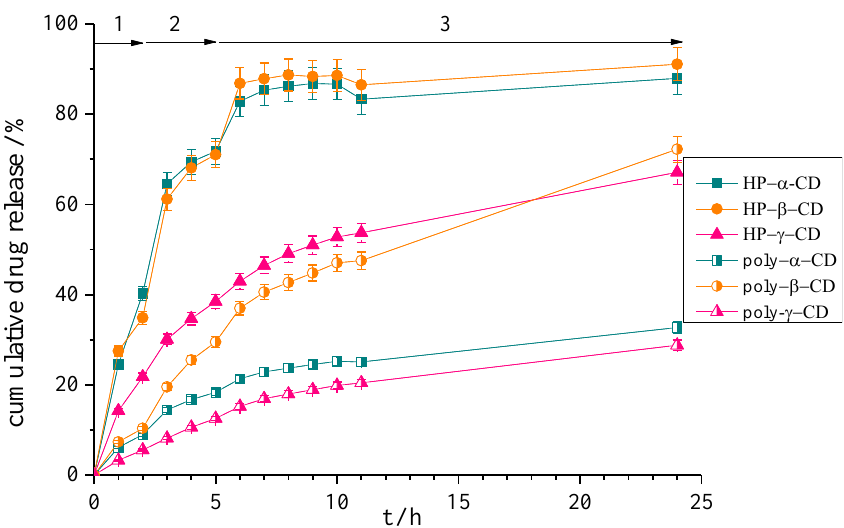
Figure 7. The cumulative curcumin release curves for the different types of cyclodextrin complexes. (Model fluids: 1 simulated gastric fluid, 2 simulated intestinal fluid, 3 colonic fluid).